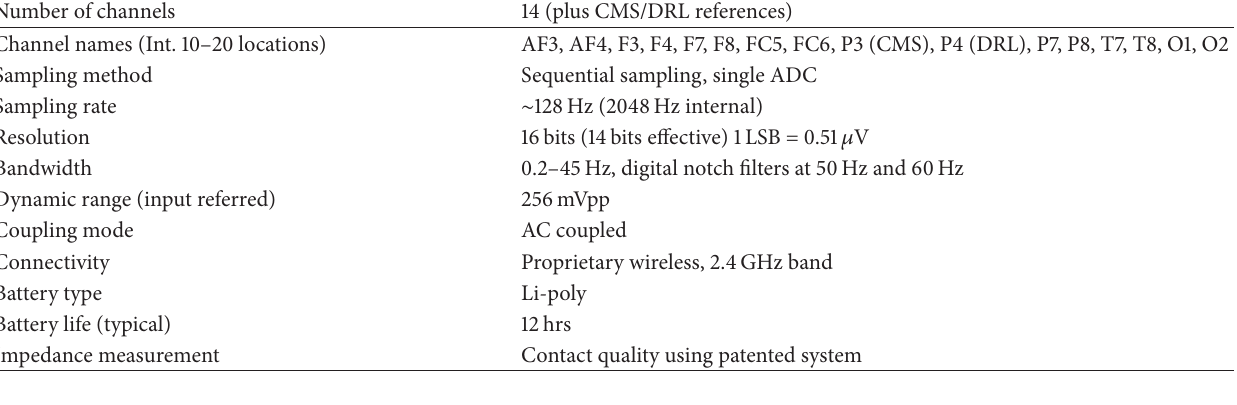
Table 1: Specifications of the Emotiv EEG Neuroheadset [12].